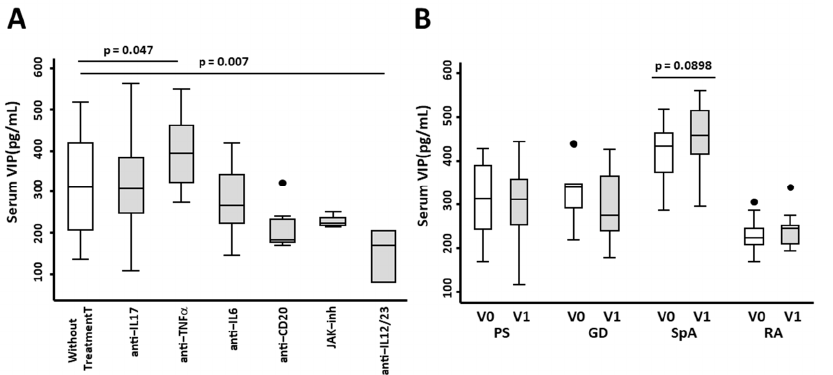
Figure 3. Effect of biological therapies on the expression of serum VIP levels in patients with immune-mediated inflammatory diseases (IMIDs). ( A ) Serum VIP levels (pg/mL) of 38 healthy donors without treatment and 9 IMID patients with anti-IL17 treatment, 15 with anti-TNF α treatment, 10 with anti-IL6 treatment, 8 with anti-CD20 treatment, 4 with JAK inhibitors, and 2 with anti-IL12/23 treatment are shown. Statistical significance was calculated using the variable of serum VIP levels normalized by inverse square root and applying ANOVA and Bonferroni correction for multiple comparisons to obtain the p -values as indicated. In all panels, data are